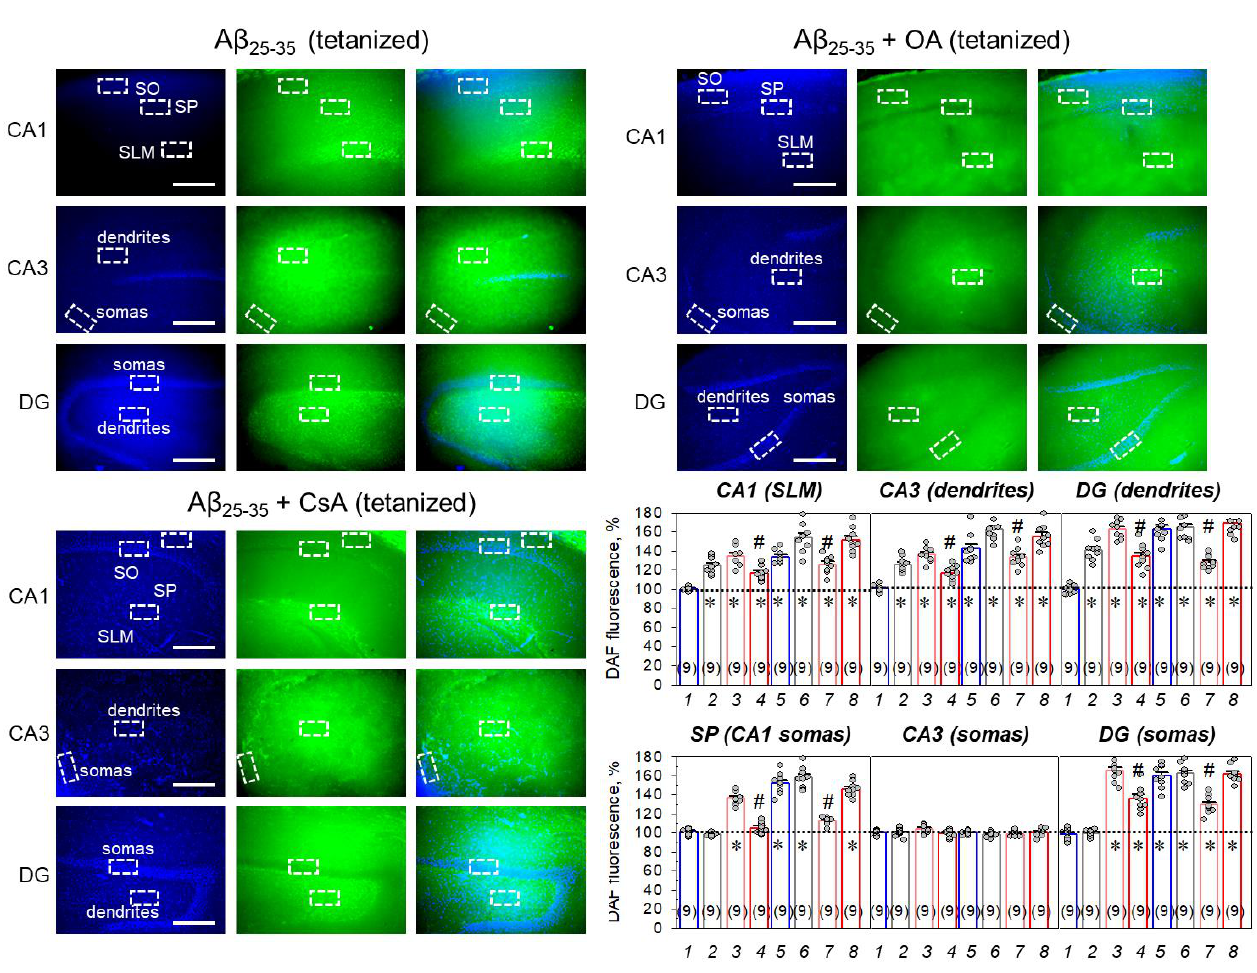
Figure 7. NO staining by DAF-FM dye in the tetanized A β 25-35 -treated slices without or in the presence of STPP blockers, okadaic acid (OA, 100 nM), or cyclosporin A (CsA, 5 µ M). SP—stratum pyramidale, SLM—stratum lacunosum-moleculare (SLM), DG—dentate gyrus. Blue fluorescence channel indicates staining of cell nuclei by DAPI. Scale bars 300 µ m. In histograms, summarized statistics are presented for DAF-fluorescence in dendrite-containing regions of CA1, CA3, and DG layers (top panels) as well in somas of CA1, CA3, and DG layers (bottom panels). Groups in diagrams: 1—control; 2—tetanus; 3—A β 25-35 ; 4—A β 25-35 + OA; 5—A β 25-35 + CsA; 6—A β 25-35 + tetanus; 7— A β 25-35 + tetanus + OA; 8—A β 25-35 + tetanus + CsA. Number of independent slices is indicated in parentheses; * denotes p < 0.05 for comparison to the control; and #— p < 0.05, when groups are compared between